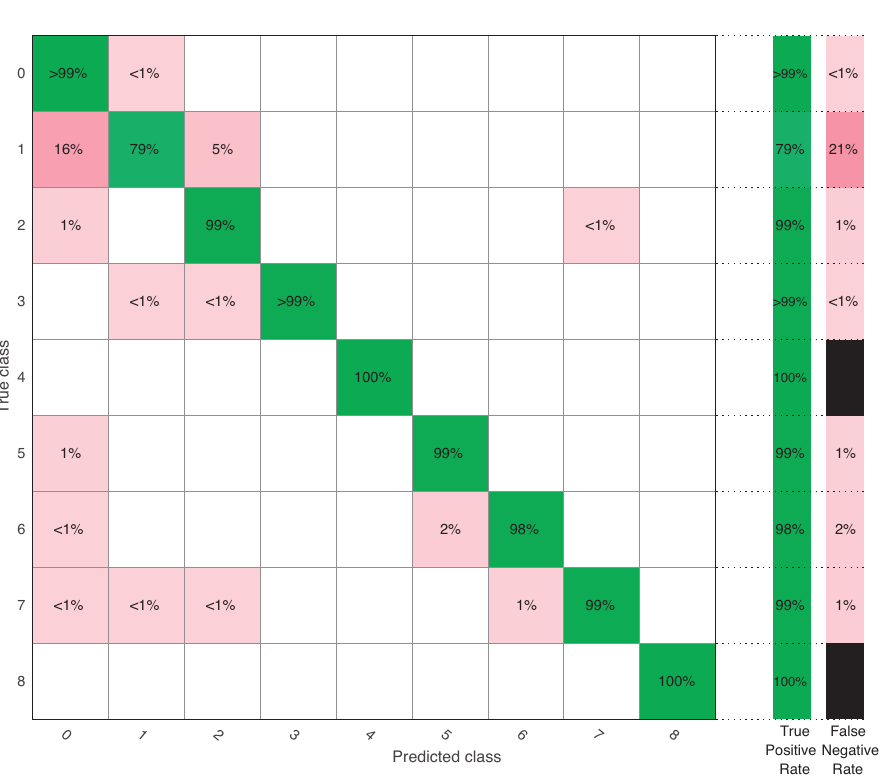
Figure 7. Confusion matrix when J =